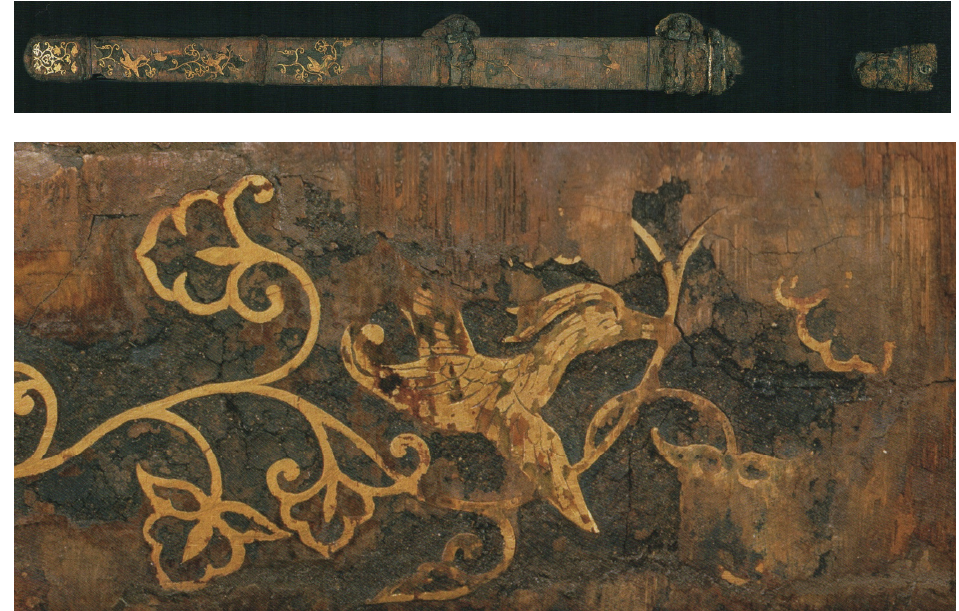
Figure 8. Sword with motif of birds and grape vines on the scabbard. Discovered from the north cavity from beneath the Seated Vairocana Buddha, T ō daiji. Nara period, mid 8th century. In the collection of T ō daiji. Reproduced from T ō daiji My ū jiamu (2013), pp.